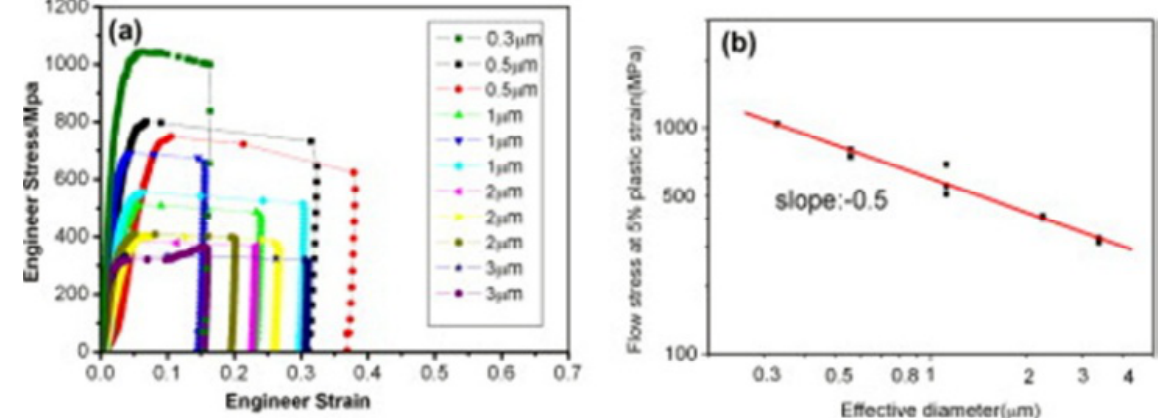
Fig. 32. Size effect in the flow stress of Ti pillars. (a) Engineering stress–strain curves of compressing Ti samples with different diameters; (b) The flow stress at 5% plastic strain vs the effective diameter (the d S 4 /   ). Reprinted with permission equivalent circular pillar diameter of the square pillar; effecrive